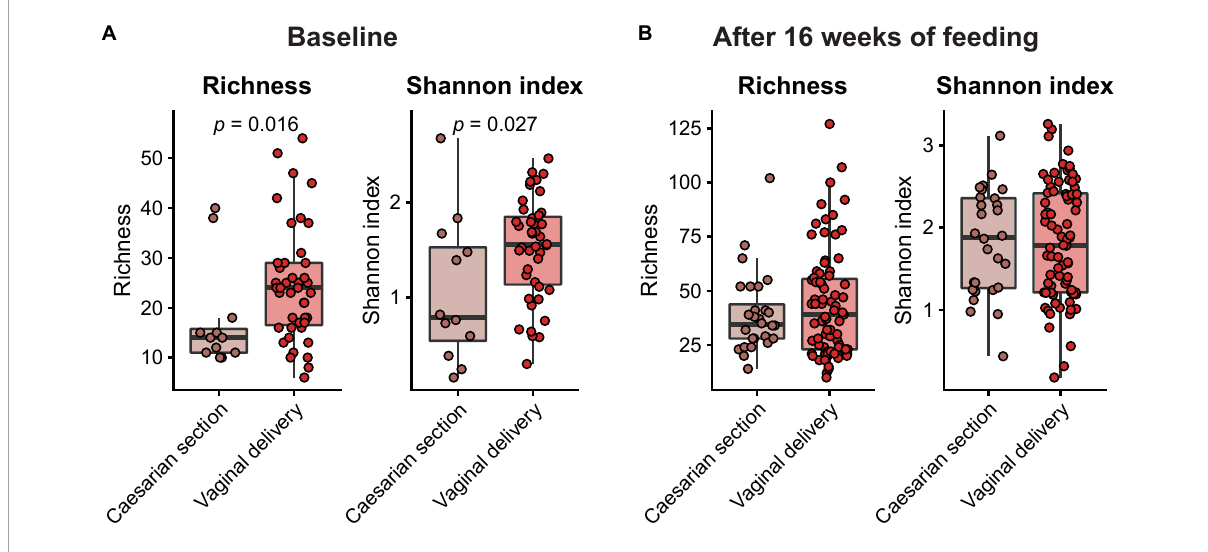
FIGURE1 Box plots of MGS richness and Shannon diversity index at baseline (A) and after 16 weeks of feeding (B) in infants born by either caesarian section or vaginal delivery. Horizontal lines indicate median; box boundaries indicate the interquartile range; whiskers represent values